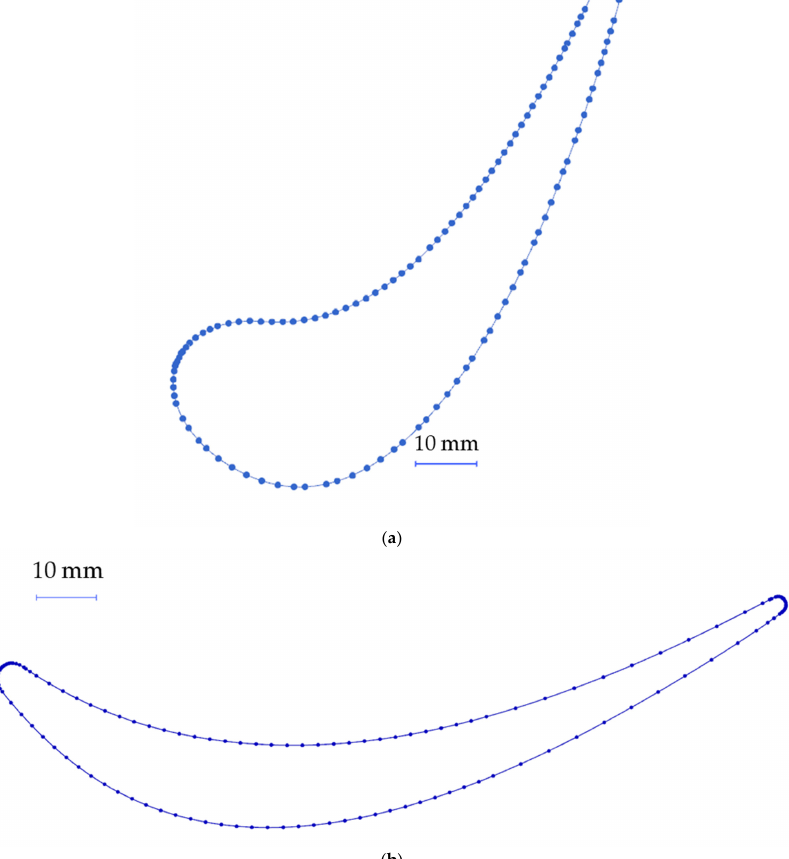
Figure 7. ( a ) Turbine guide vane control section defined by 104 Bezier curves before simplification. ( b ) Turbine blade control section defined by 127 Bezier curves before simplification. The original CAD section contains 104 smaller Bezier curves (Figure 7a), which is more than needed, as proved by other authors [15,17–26]. It was rebuilt using knot removal methods and it was concluded that for CMM measurement the number of control points can be slightly decreased, reducing it to 20–30. This recalculation will produce a simplified B-spline with looser tolerance. Examples of point reduction and errors in shape are collated in Table 1. Different scenarios were tested, decreasing the number of points from 1000 into 5. It can be noticed that with around 25 points the spline is still of good quality, having only a few control points to inspect. The follow- ing spline simplification parameters were used: three-degree Bezier curves with C2